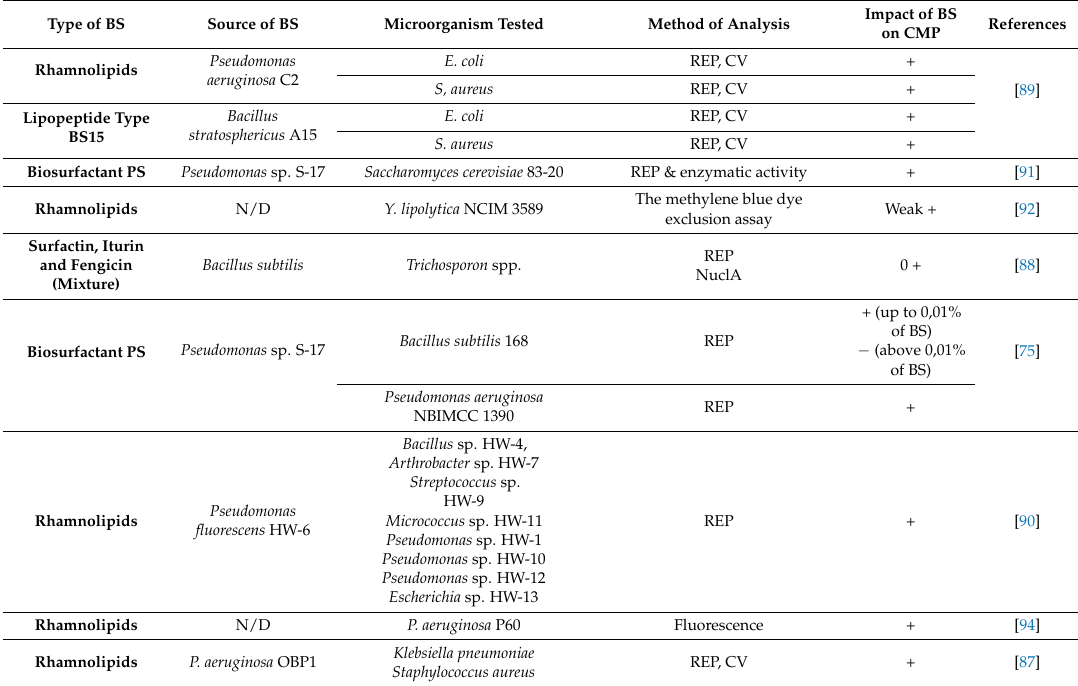
Table 3. Impact of biosurfactants on cell